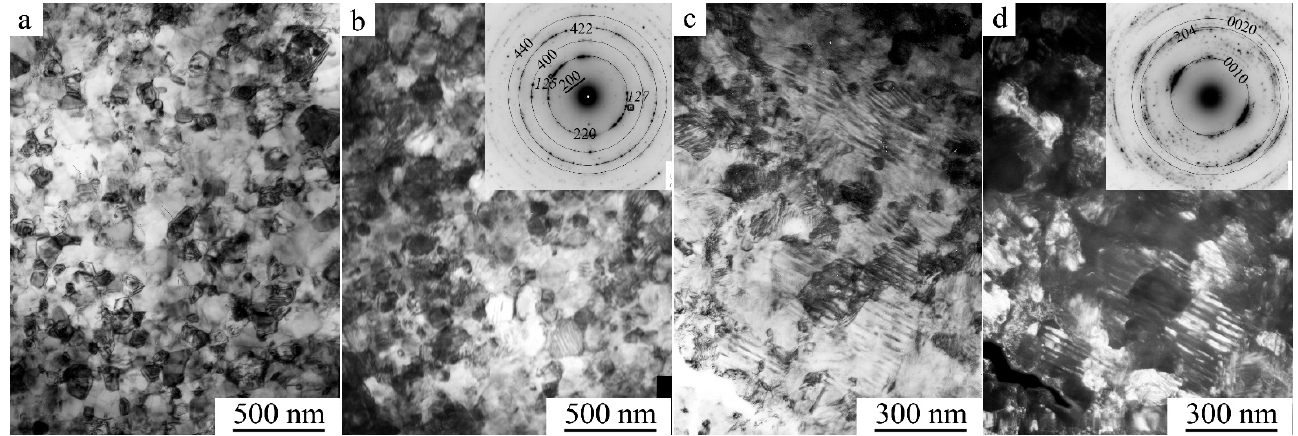
Figure 6. ( a , c ) Bright- and ( b , d ) dark-field TEM images of the microstructure and corresponding SAED patterns (in the inserts) of the Ni 50 Mn 28.5 Ga 21.5 alloy subjected to HPT at 5 GPa and five revolutions and subsequent annealing at 623 K for 10 min. Observations were performed at ( a , b ) RT and ( c , d ) 120